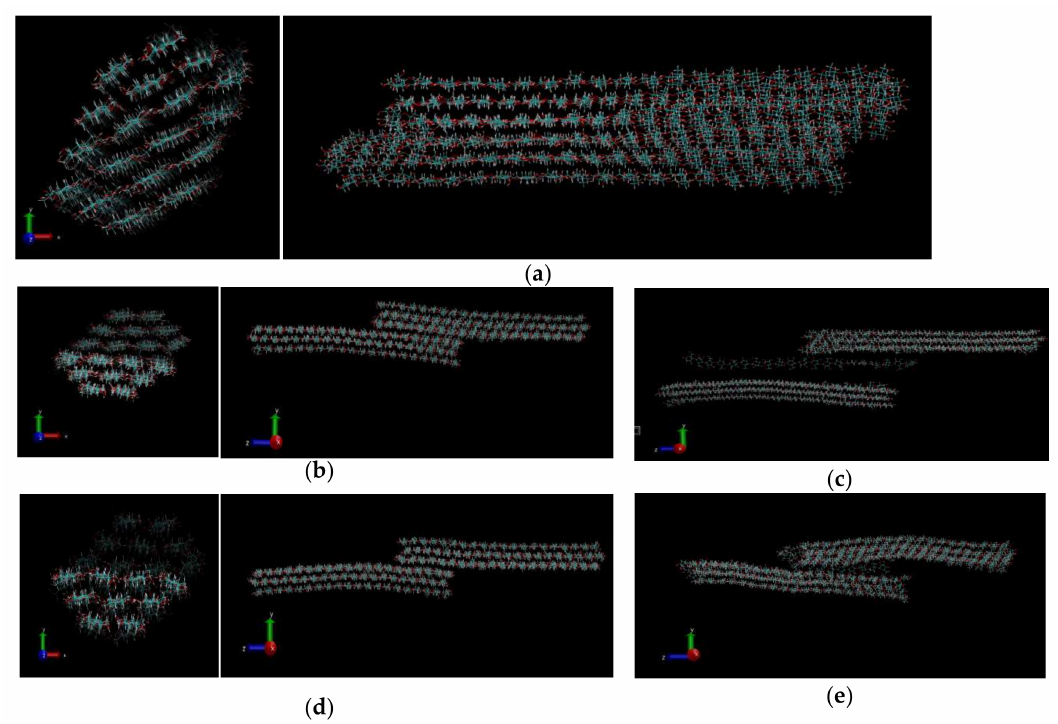
Figure 4. Case B: Structures of CNF after half pull simulations at: ( a ) 5000 kJ / mol / nm at 200 ps, ( b , c ) 10,000 kJ / mol / nm at 129 ps and 200 ps, respectively, and ( d , e ) at 50,000 kJ / mol / nm at 97 ps and 200 ps,